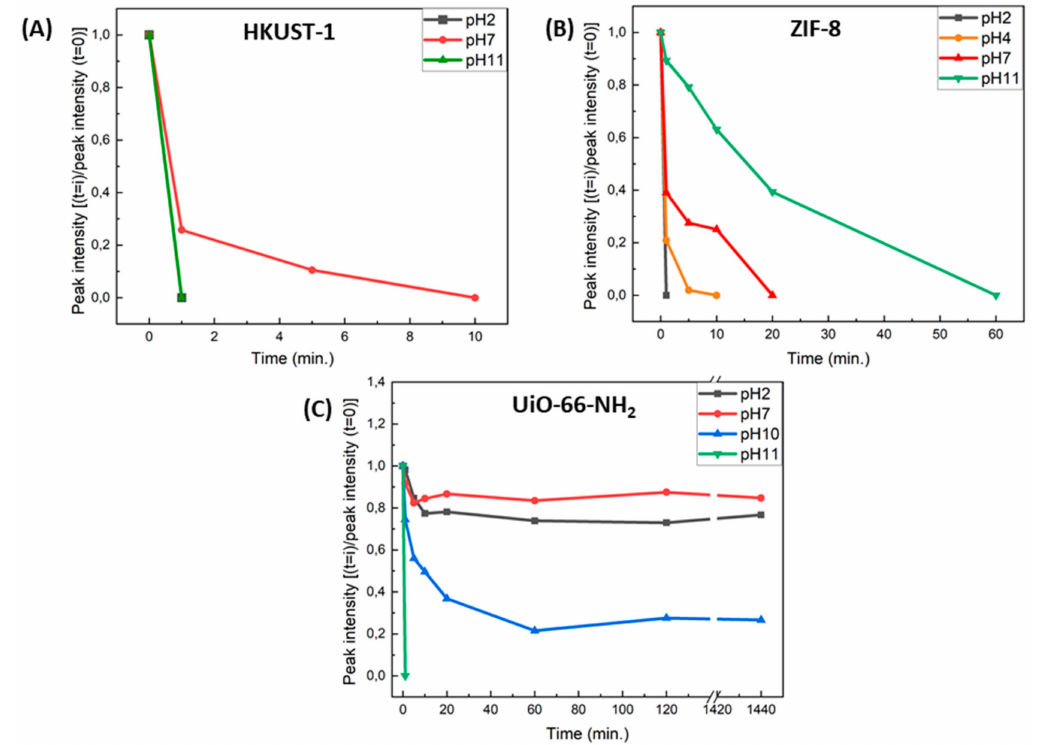
Figure 4. Summary of behavior (XRD peaks) of ( A ) HKUST-1, ( B ) ZIF-8, and ( C ) UiO-66-NH 2 SURMOFs films as a function of immersion time and pH